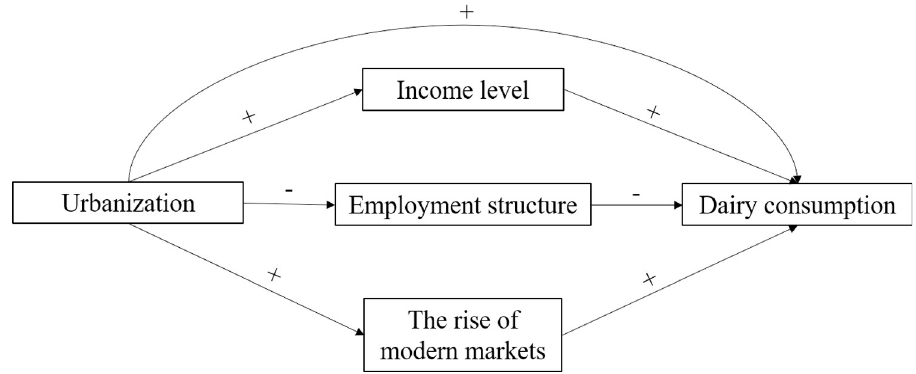
Fig 2. The relationships and influence paths between the